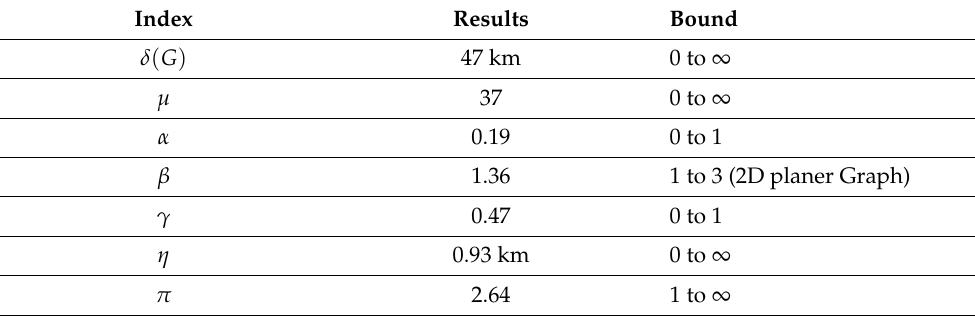
Table 3. Pre-earthquake network level-based